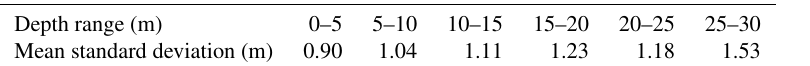
Figure 11. Assessment of the accuracy of the SDB using LADS data. In the vicinity of Barrow Island and Onslow, 4200km 2 of LADS data overlaps the SDB data (a) . Over 16000 points were extracted along a mesh of 1000 × 1000m from both datasets and plotted against each other to assess the accuracy of the SDB data (b) . There is a strong correlation between both datasets as highlighted by the cross section (c) . Some points seem to diverge from the main trend and reflect areas with a constant shift between the SDB data and LADS bathymetry (cross section (c) , km 125 to 140). For data sources, see Sects. 3.1, 3.6, and 5.2.1. Table 2. Mean standard deviation per depth range.